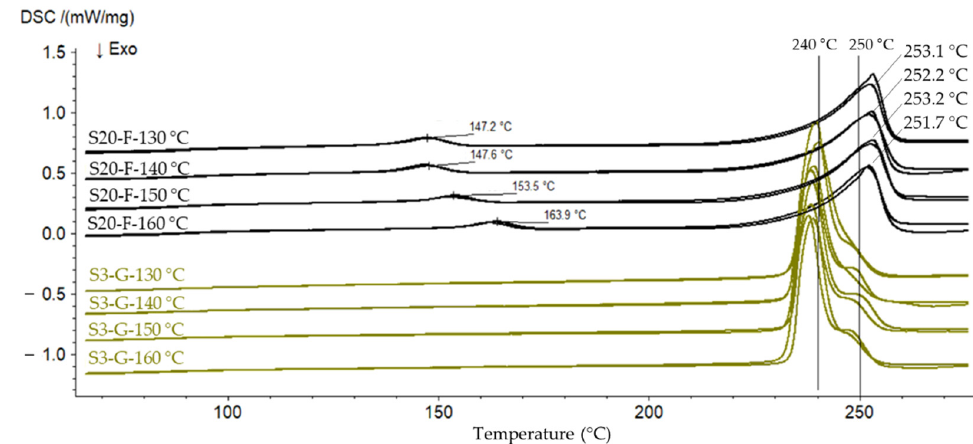
Figure 5. Melting curves of commercially granulated rPET (S3-G) and laboratory granulated rPET flakes (S20-F) dried at different temperatures from 130–160 °C.